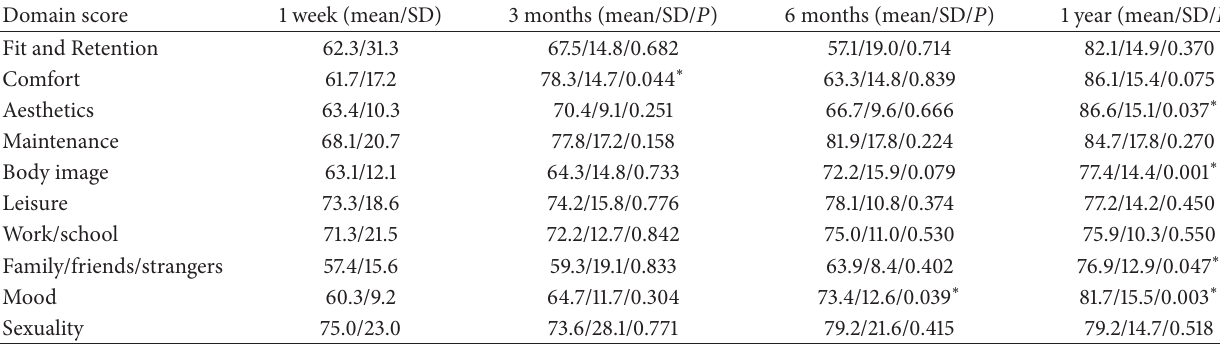
Table 5: TOMCP scores over the time points.